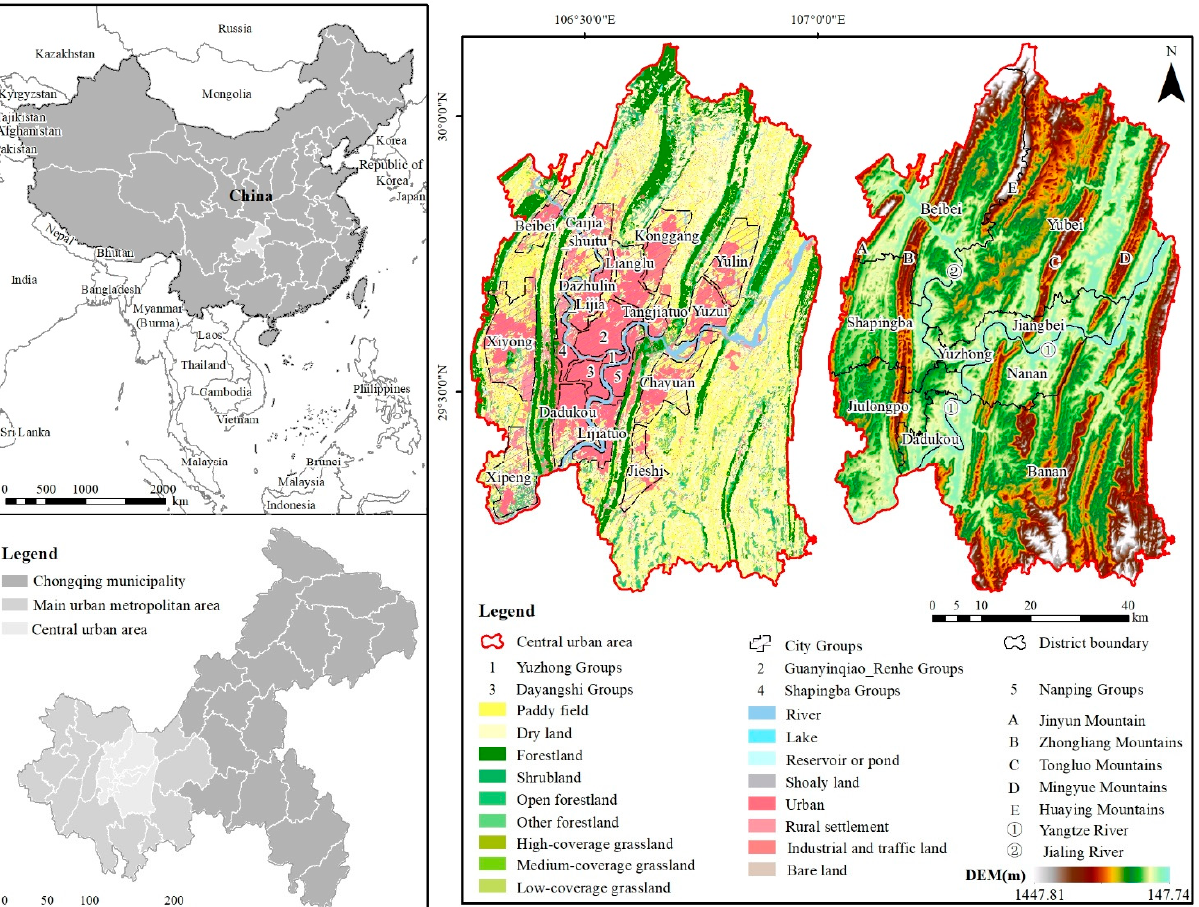
Figure 1. Location, land use types in 2018 and digital elevation model of the central urban area Chongqing municipality.